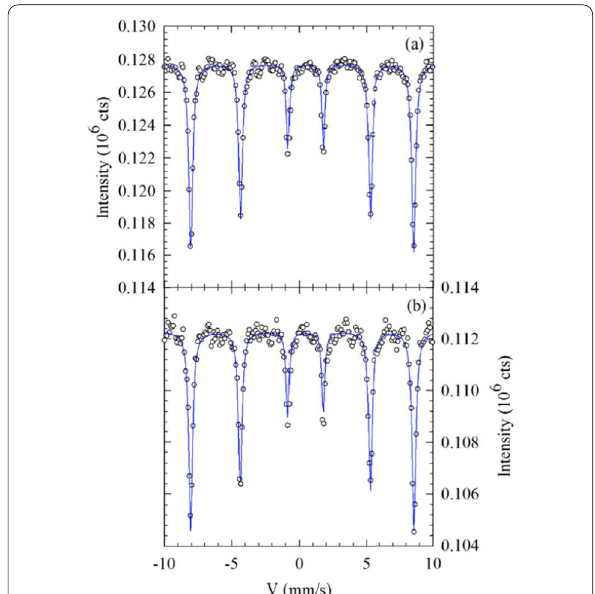
Fig. 7 57 Fe Mössbauer spectra recorded at room temperature for